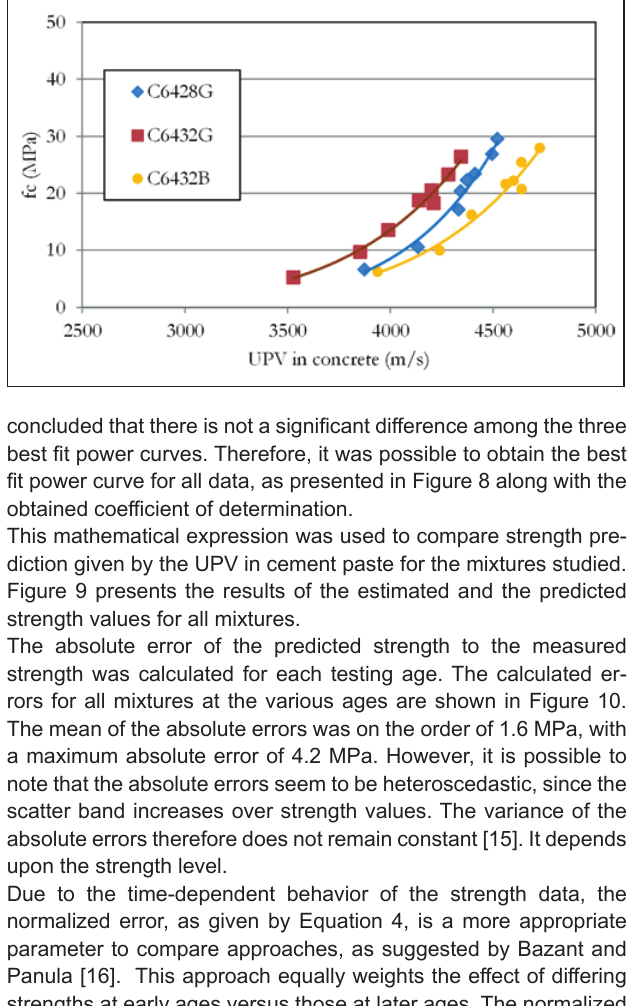
Figure 4 – Comparison among UPV values for concrete mixtures with w/c of